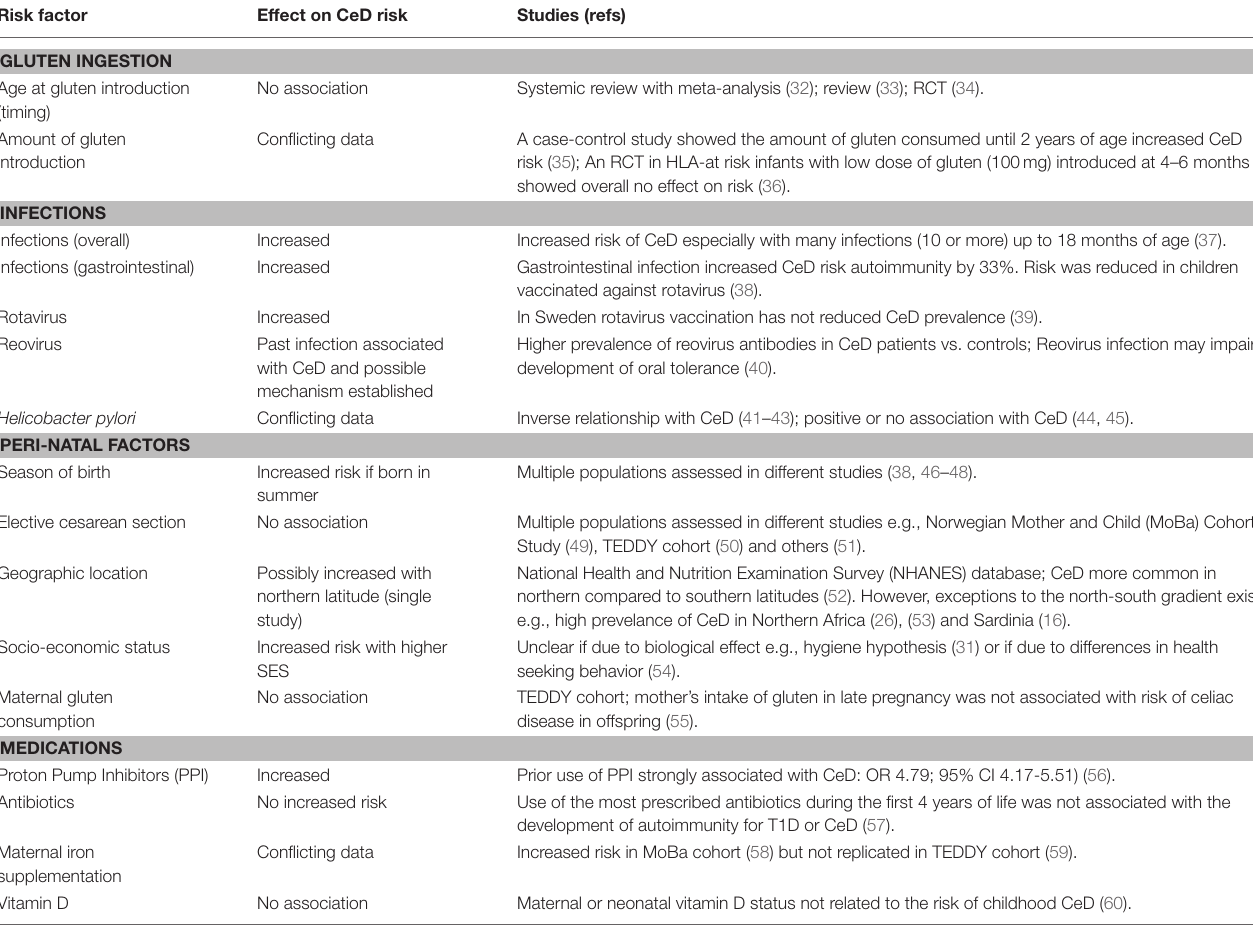
TABLE 1 | Environmental factors potentially associated with CeD